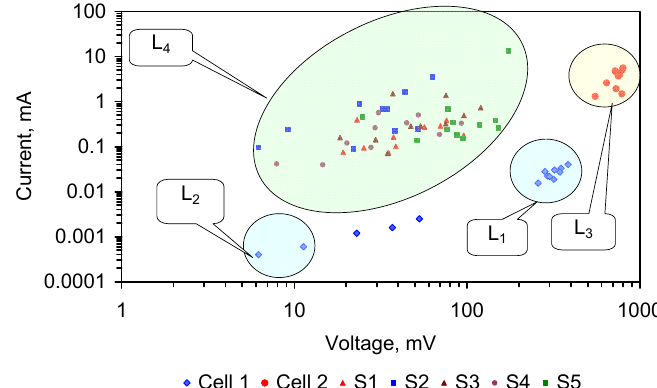
Figure 13. Relationship between voltage and current associated with used ZVM TP pellets following desalination (ST1a to ST5j), L 4 , and the unused ZVM TP prior to desalination, Cell 1 (L 1 , L 2 ) and Cell 2 (L 3 ). The pellet series are labeled S1 to S5 to distinguish them from the analyses (ST1a to ST5j) in Appendix C, as the measurements were made 2 years after termination of the desalination